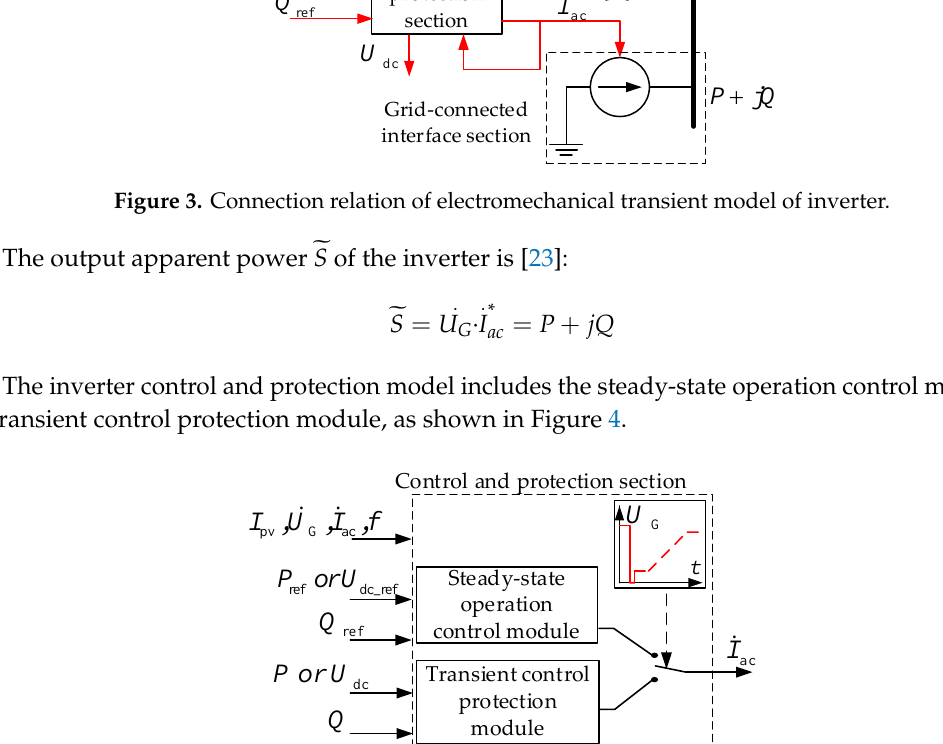
Figure 5. Steady-state operation control module of inverter. The DC voltage calculation module simulates the stable voltage of the DC capacitor of the inverter. The active power control module tracks the maximum power point voltage (or control command at plant-level) of the PV array, and outputs the inverter current active component I d . The block diagram of the active power control module with U dc as the controlled object is shown in Figure 6. d I Figure 6. Block diagram of active power control module. The reactive power control module takes the reference value of reactive power as the control target and outputs the inverter current reactive component I q , as shown in Figure 7. - _ sT  Figure 7. Block diagram of reactive power control module.